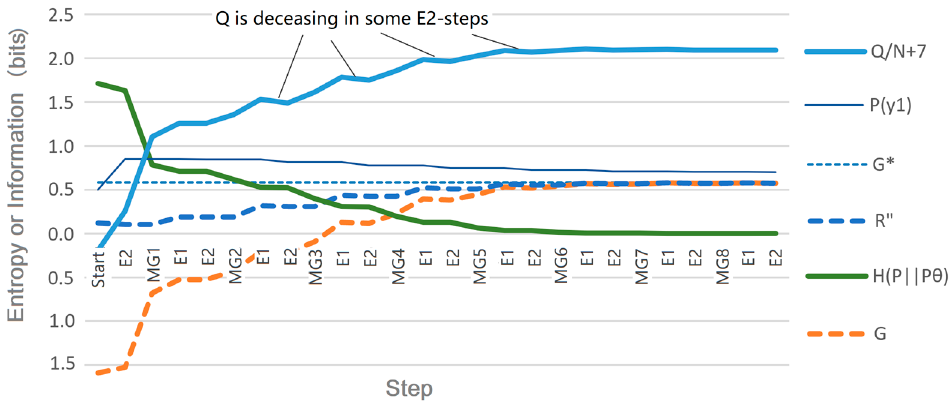
Figure 14. The iterative process of the CM-EM algorithm for Example 6. It can be seen that some E2-steps decrease Q . The relative entropy is smaller than 0.001 bit after nine iterations.